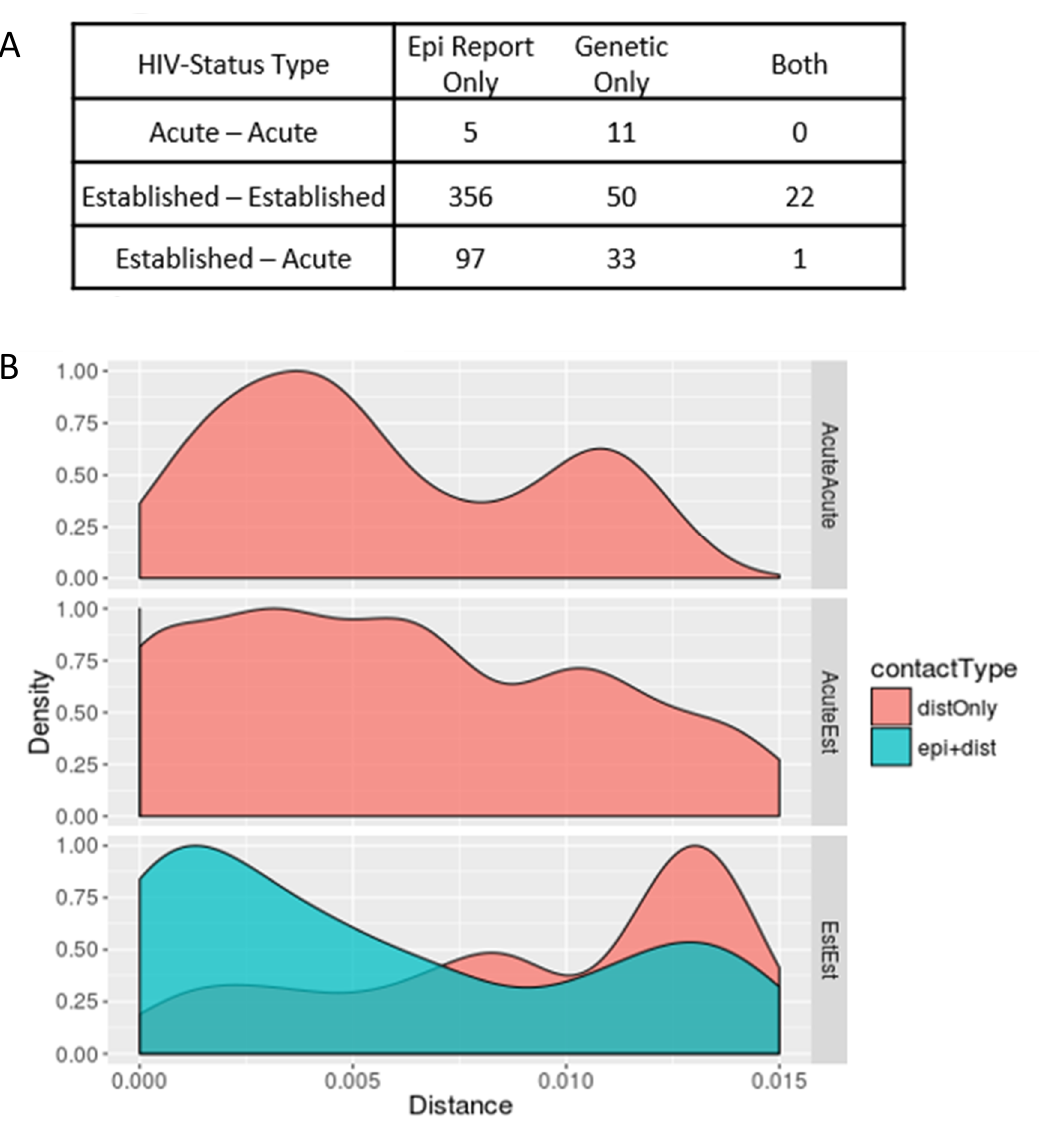
Figure 1. Contact and close genetic links, categorized by recency of HIV infection and type of reported contact. Links between participants were categorized according to the recency of infection, i.e., Acute-to-Acute (AcuteAcute), Acute-to-Established (AcuteEst) or Established-to-Established (EstEst). Links were also categorized by contact type, indicating whether a link was reported, genetically inferred (distOnly) or both (epi + dist). ( A ) Represents the counts of each category of link that was observed. ( B ) Kernel density plots of the pairwise genetic distances ( x -axis), broken out by recency classification and colored by contact type (distOnly or epi + dist). Kernel density plots are smoothed and normalized functions designed to capture the density of observations at an arbitrary value, enabling comparison of disparate distributions, similar to a